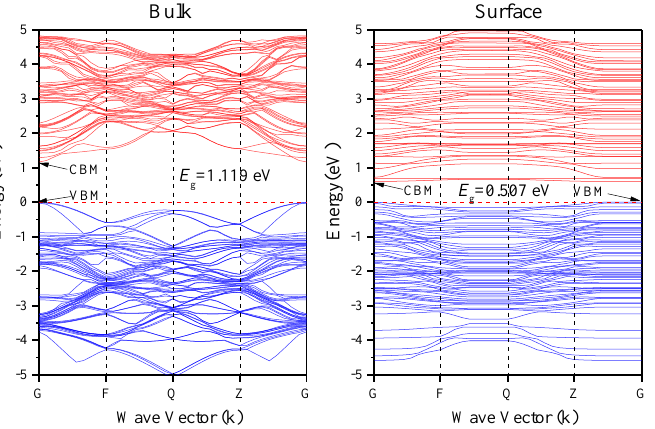
Figure 3. Band structure of bulk In 0.87 Ga 0.13 As 0.25 P 0.75 and In 0.87 Ga 0.13 As 0.25 P 0.75 (001)β 2 (2×4) surface.